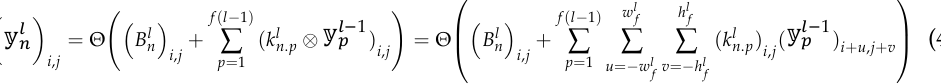
Figure 2. Architecture of the ConvXGB model.